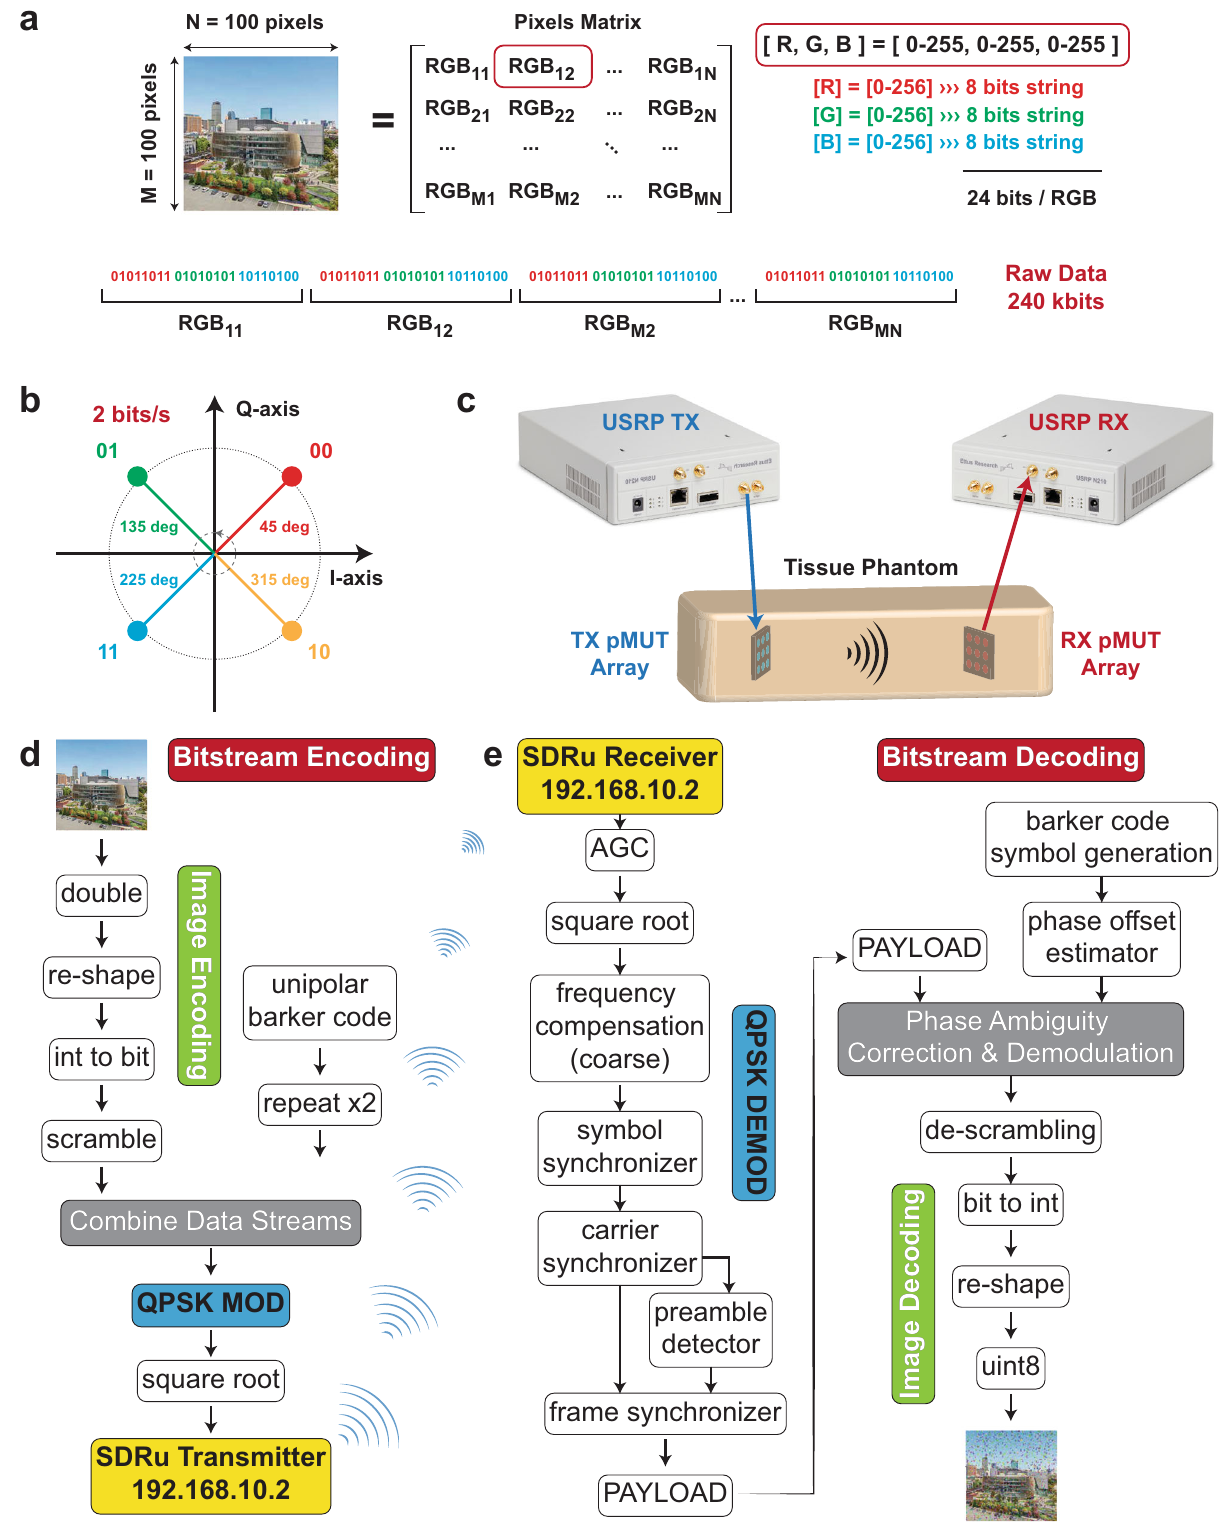
Fig. 9 Data encoding and communication scheme. a Image encoding. b QPSK constellation. c Testing setup. A power ampli fi er was used to boost the output voltage of the TX USRP and a charge ampli fi er was used to detect the incoming signal at the RX USRP. Both TX and RX are pMUT arrays. d A 100 × 100 pixels image of the Northeastern University campus is serialized into a bitstream in MATLAB. Further, this is encoded with a QPSK modulation and transmitted over an USRP in Simulink. e The transmitted data is received over the ultrasonic channel and synchronized with a second USRP in Simulink. Finally, the data is decoded from the QPSK modulation and re-shaped into a 2D RGB